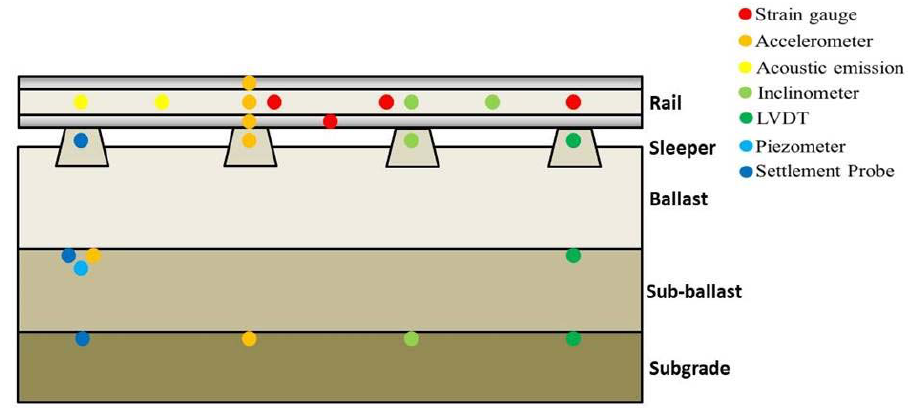
Figure 3. Schematic location of the sensors used for condition monitoring.